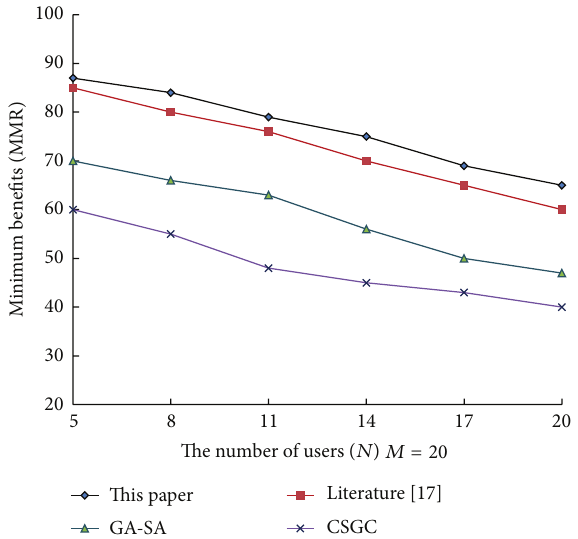
Figure 5: Influence of number of cognitive users on MMR.